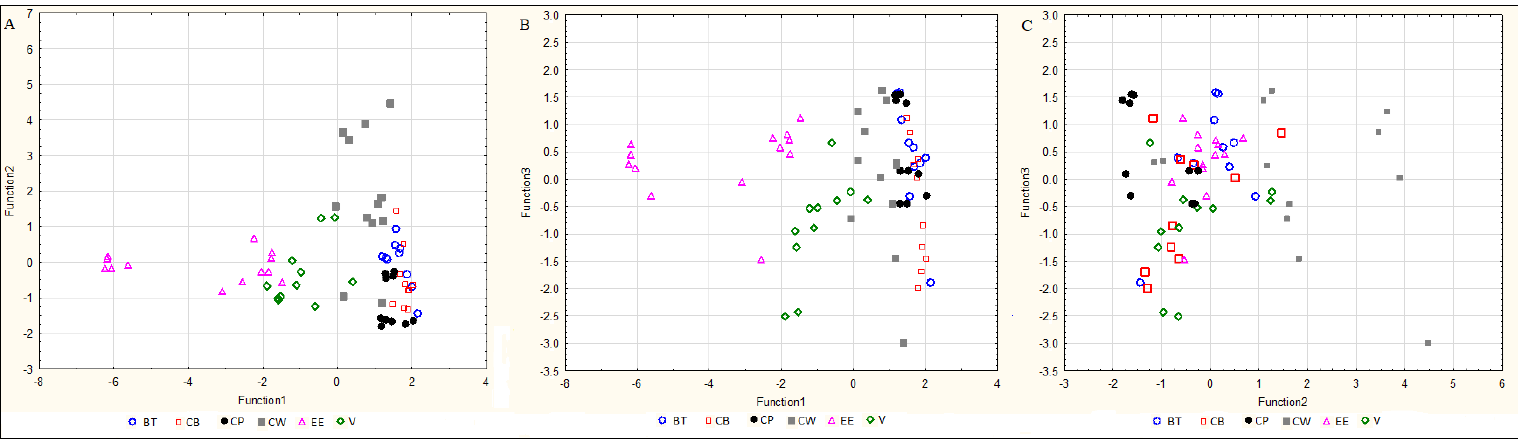
Figure 7. Discriminant analysis of pickled freshwater fish. CB — common bream, CP — common perch, CR — common roach, CW — common whitefish, EE — European eel, PP — pike-perch, V — vendace. ( A ). Function 1 vs. function 2, ( B ). Function 1 vs. function 3, ( C ). Function 2 vs. function 3.